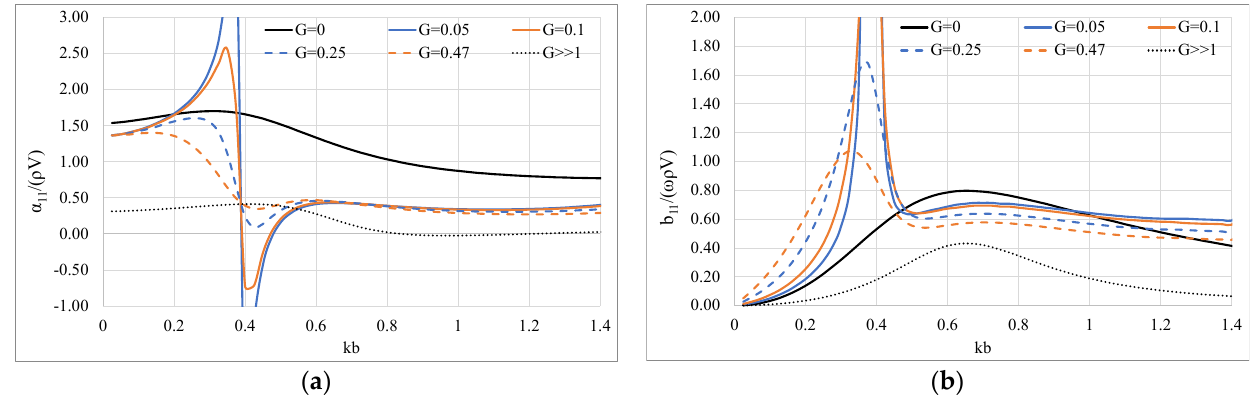
Figure 12. Effect of the porous coefficient 𝐺 on the horizontal hydrodynamic coefficients of a floating porous compound cylindrical body: ( a ) added mass; ( b ) damping coefficient.